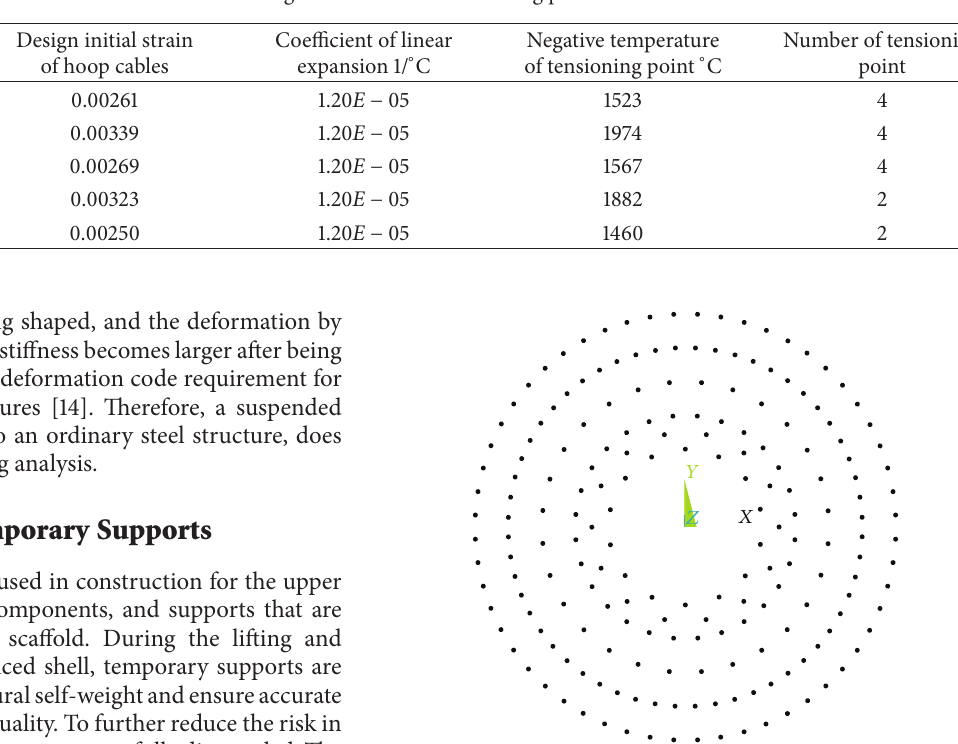
Table 2: The design initial strain of tensioning point.